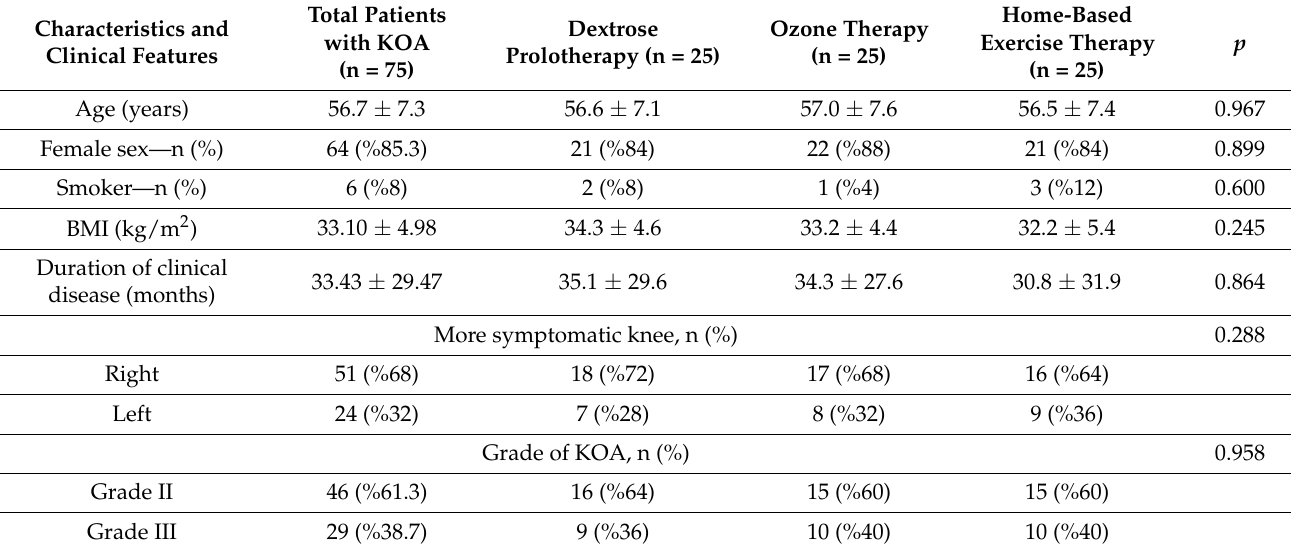
Table 1. The demographical and clinical characteristics of the